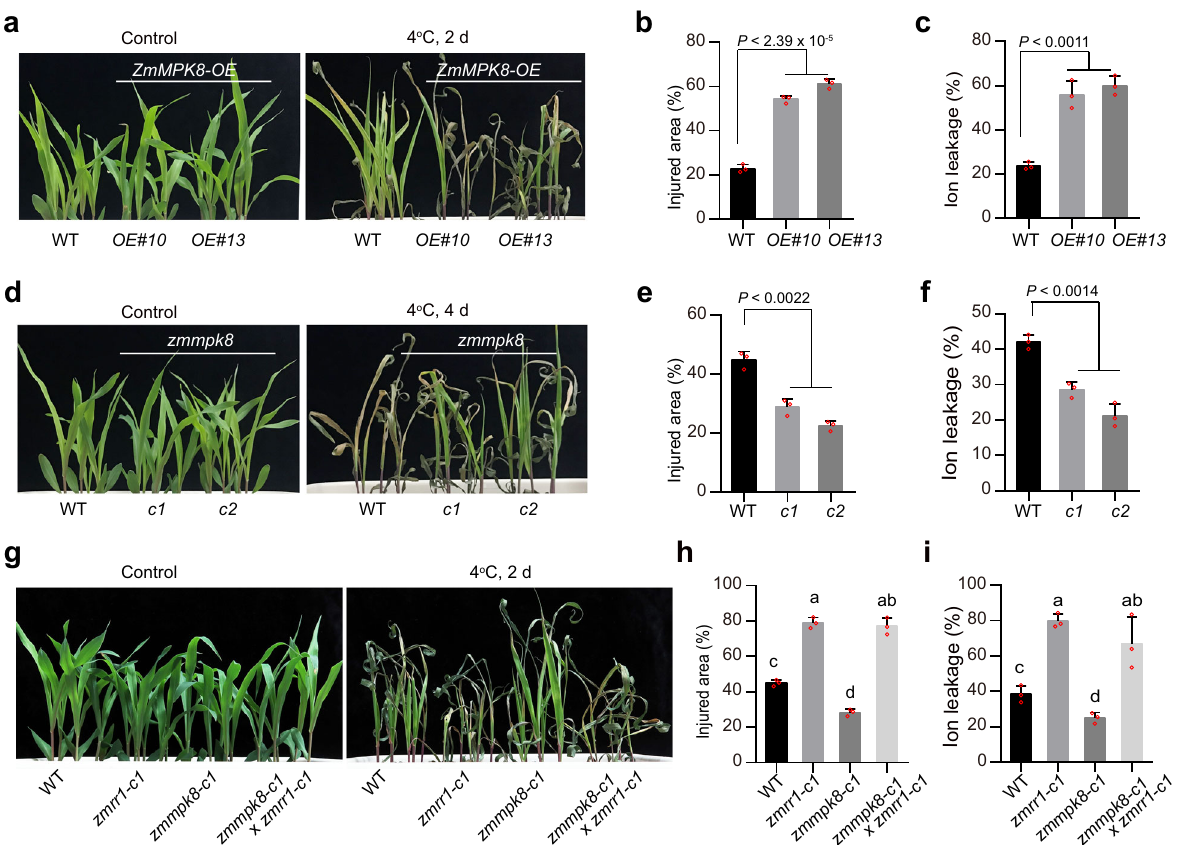
Fig. 3 ZmMPK8 negatively regulates chilling tolerance. a – c Chilling phenotypes ( a ), injured area ( b ), and ion leakage ( c ) of ZmMPK8 -overexpression transgenic plants after cold treatment. d – f Chilling phenotypes ( d ), injured area ( e ), and ion leakage ( f ) of zmmpk8 ( c1 and c2 ) mutants after cold treatment. g – i Genetic interaction of ZmRR1 and ZmMPK8 . Chilling phenotypes ( g ), injured area ( h ), and ion leakage ( i ) of zmrr1-c1, zmmpk8 - c1 , and zmrr1 zmmpk8 double mutants after cold treatment were shown. In b , c , e , f , h, i , each bar represents the mean ± SD of three independent experiments. In b , c , e, f , the statistical signi fi cance was determined by a two-sided t -test. In h and i , different letters represent signi fi cant differences ( P < 0.05, one-way ANOVA). Source data underlying Fig. 3b, c, e, f, h, and i are provided as a Source Data fi